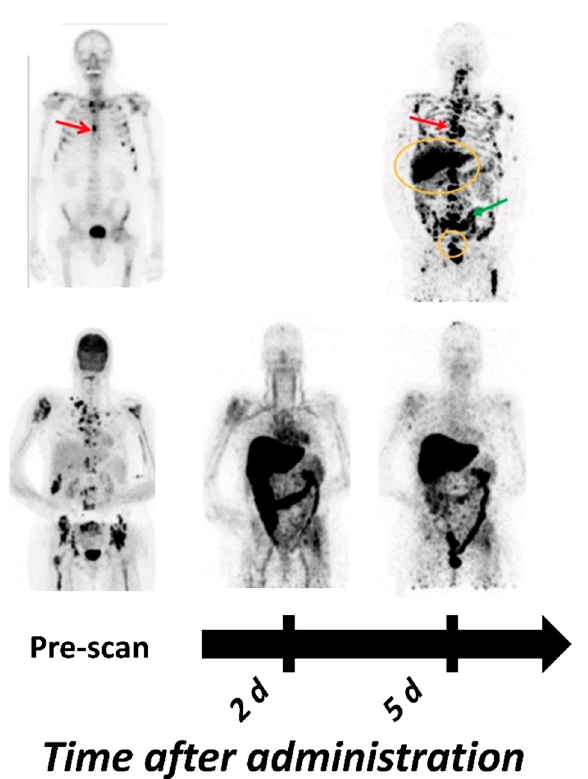
Figure 5. Imaging of HER3 expression in patients with bone (upper row, prostate cancer, red and green arrows) and soft tissue (bottom row, breast cancer) metastases using mAb [ 89 Zr]Zr- GSK2849330 [251]. Pre-scan images using bone scan SPECT (top) and 18 F-FDG (bottom) are given for comparison. These images were originally published in JNM [251]. © SNMMI.